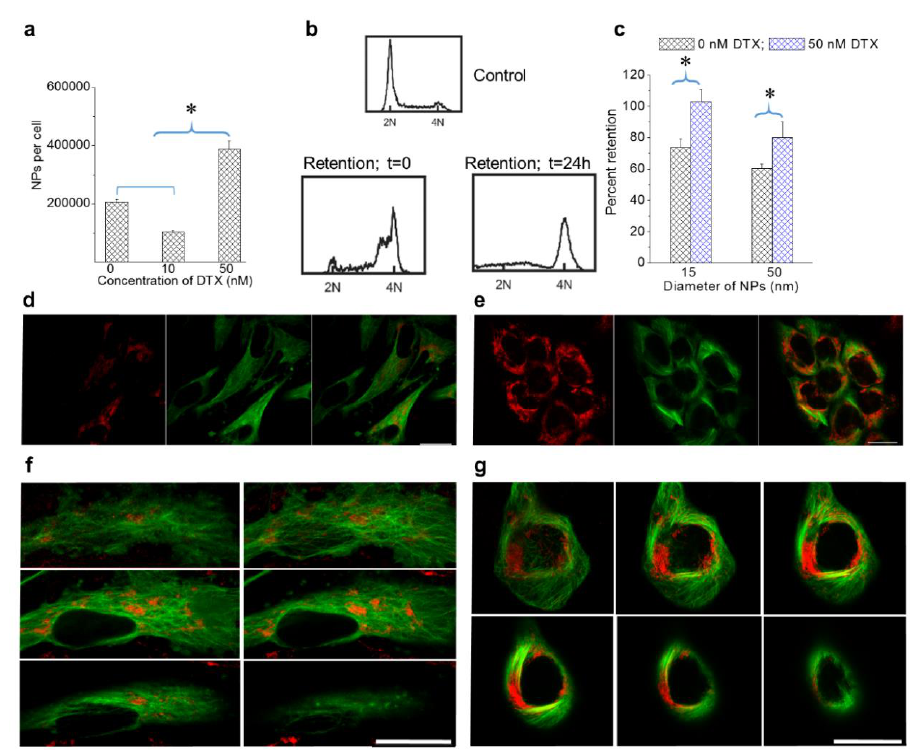
Figure 4. Retention of NPs in cells treated with DTX. ( a ) Retention of NPs in DTX-treated cells after 24 h. ( b ) Cell cycle analysis for control HeLa cells and cells treated with 50 nM DTX at the beginning and end of the retention. ( c ) NP size-dependent retention in MDA-MB-231 cells treated with 50 nM DTX. ( d , e ) Images corresponding to control cells and cells treated with 50 nM DTX after 24 h, respectively. ( f–g) Z-stack showing the distribution of NPs in different planes following the retention process in a control cell and a cell treated with 50 nM DTX, respectively. Vesicles containing GNPs and MTs are marked in red and green, respectively. Scale bar is 20 µm. Error bars are standard deviations from 3 replicate measurements. *Represents a statistically significant difference (Welch’s unequal variance t-test, p < 0.05).